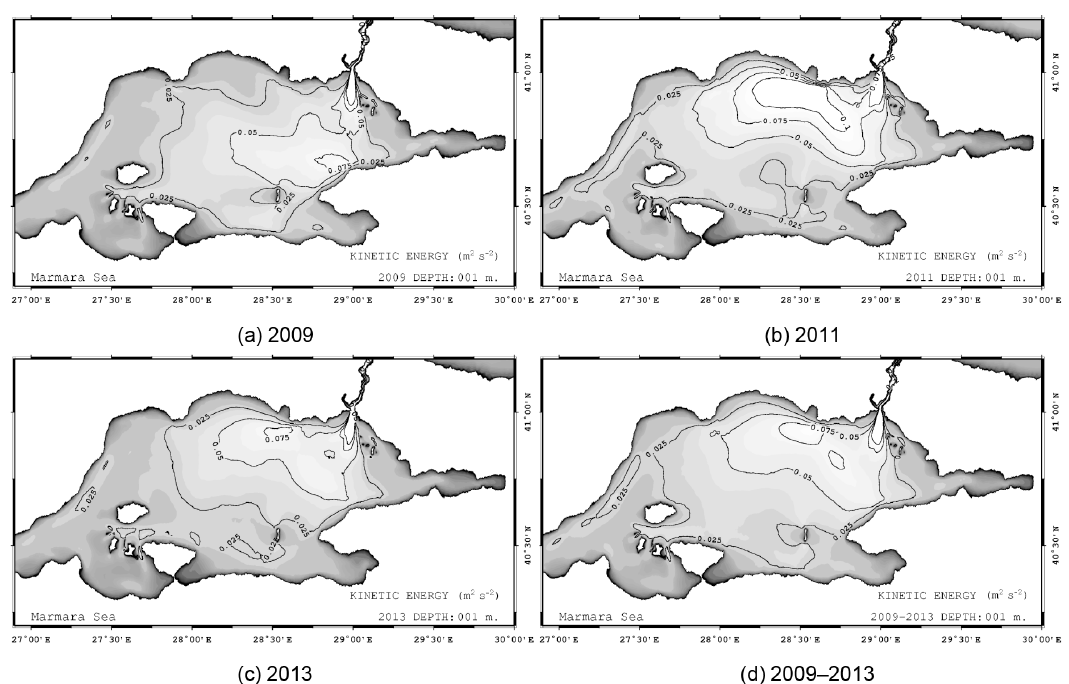
Figure 16. Annual mean of surface kinetic energy in the Sea of Marmara for (a) 2009, (b) 2011 and (c) 2013. (d) The time mean of the 2009–2013 period. Units are in m 2 s − 2 as kinetic energy is normalised by the unit mass.